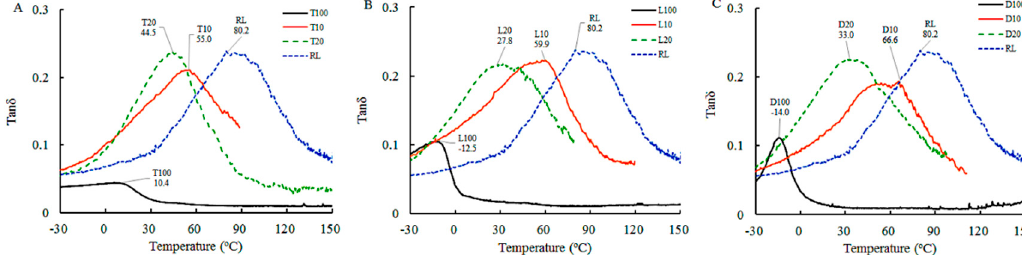
Figure 2. Tan δ of OMRL films: ( A ) Tung oil (TO)-modified refined lacquer; ( B ) linseed oil (LO)-modified refined lacquer; and ( C ) dehydrated castor oil (DCO)-modified refined lacquer.